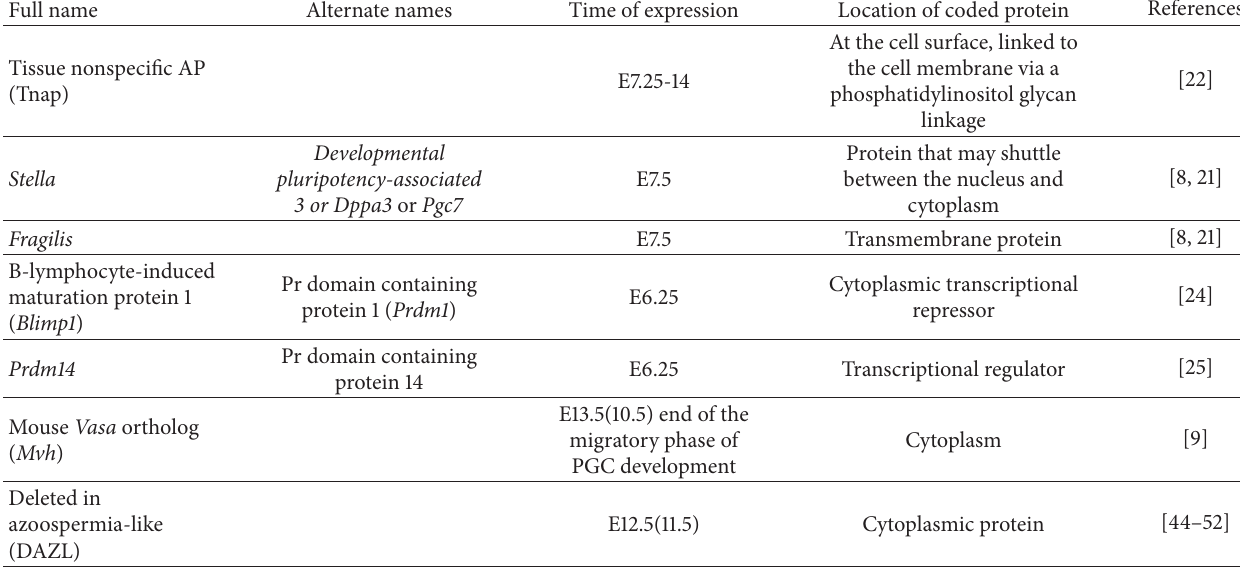
Table 1: Summarized genes that participate into PGC